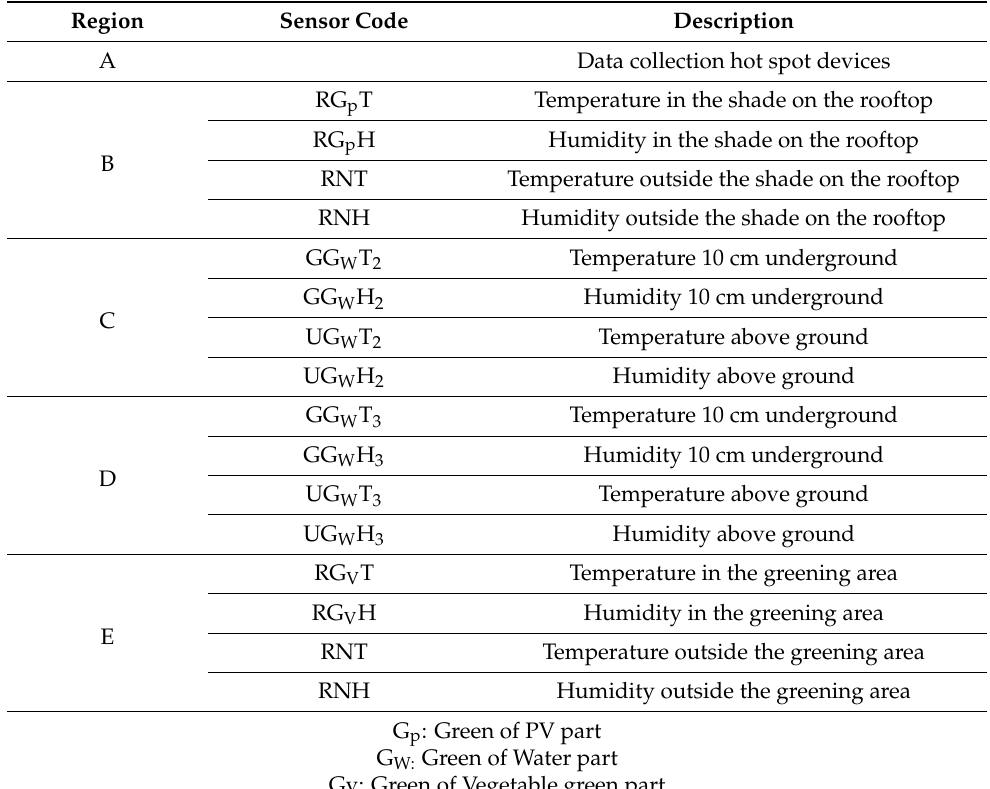
Table 6. Sensor serial